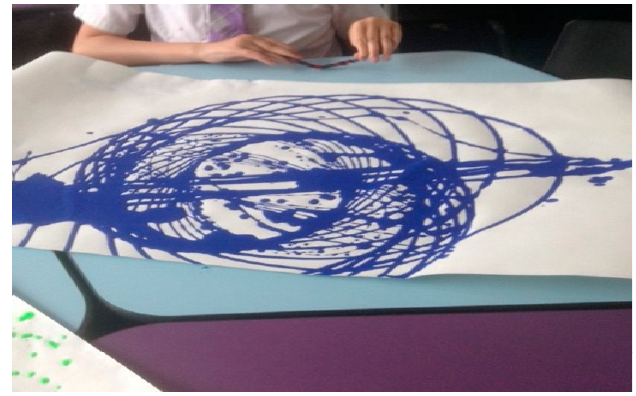
Figure 9. Pendulum painting with Ted. Reenacting movement in class.